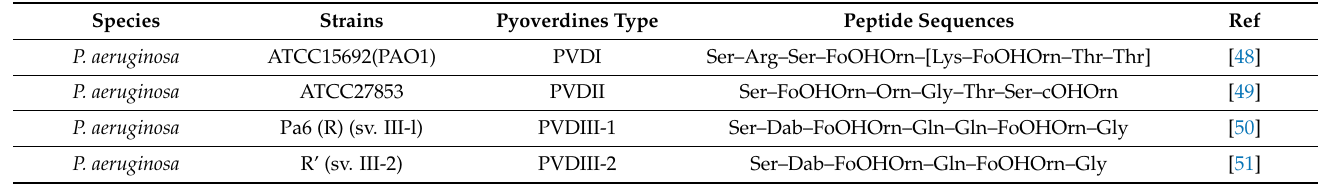
Table 1. Pyoverdines that are synthesized by P. aeruginosa